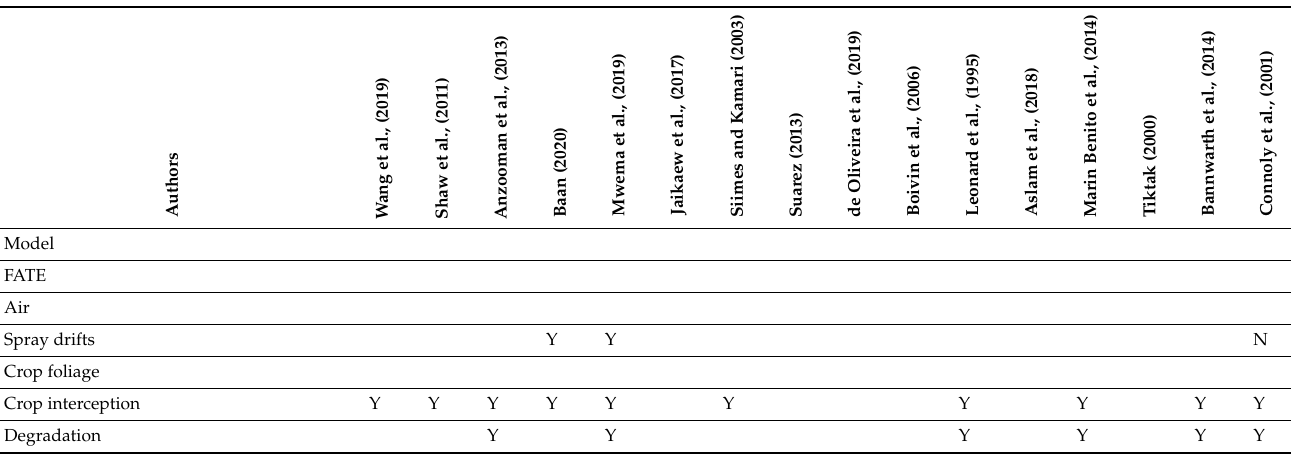
Table 5. Modelling studies or reviews performed on pesticide fate and transport on various